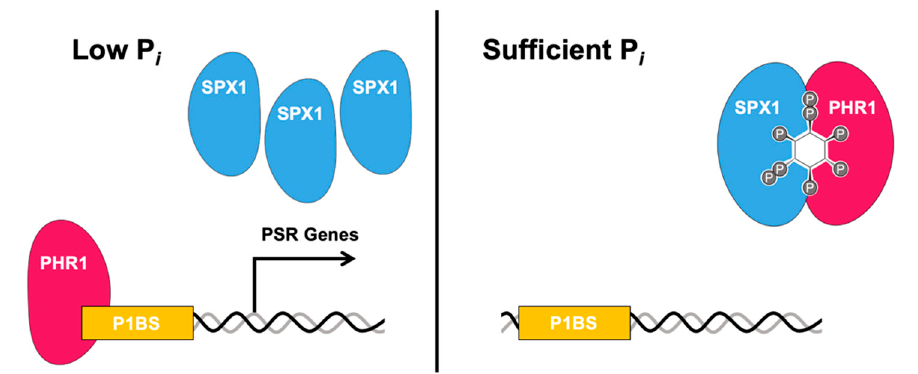
Figure 2. Model of PP-InsP regulation of the plant P i starvation response. Under low P i conditions (left), transcription factor PHR1 binds to P1BS-containing promoters. Under sufficient P i conditions, SPX1 interacts with PHR1 via PP-InsPs, preventing PHR1 from binding to P1BS-containing promoters. Adapted from [71].